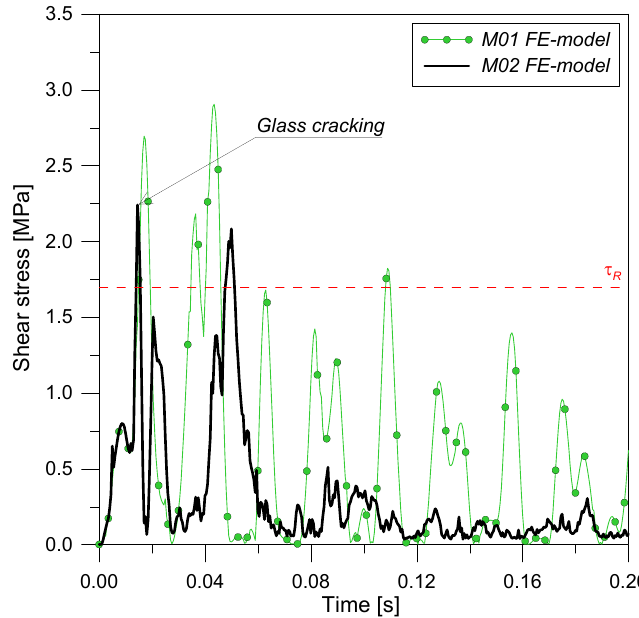
Figure 14. Comparison of maximum envelope of shear stresses in the bead of structural